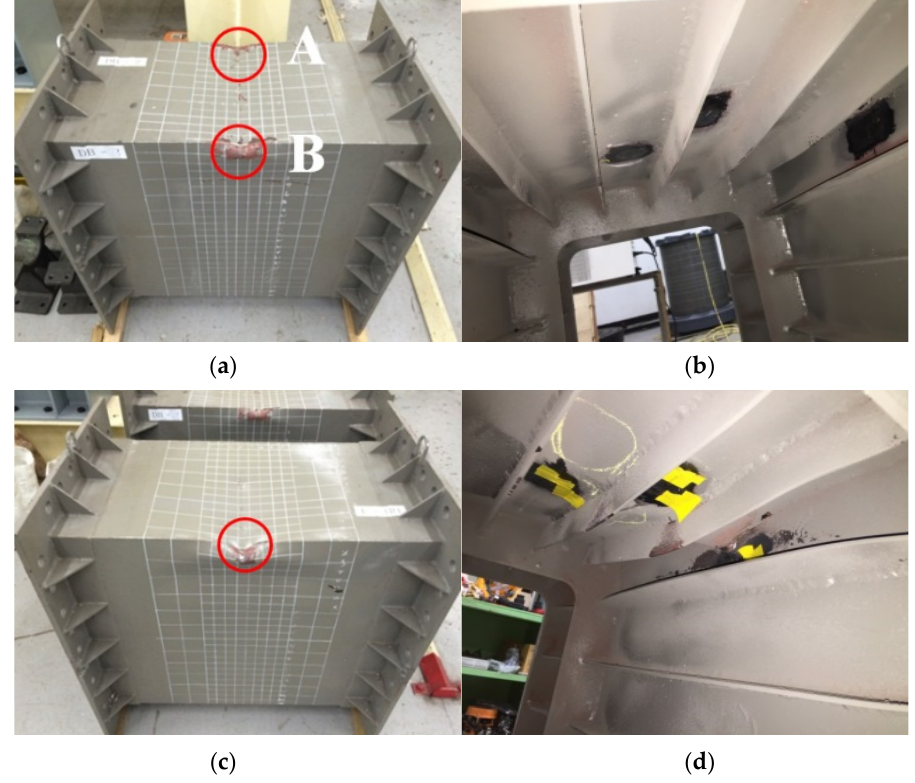
Figure 7. The deformed shape of the model: ( a ) DB-2: exterior view (showing locations A and B where the dent depth were measured); ( b ) DB-2: interior view; ( c ) DB-4: exterior view; ( d ) DB-4: interior view. Table 3. Conditions of the collision tests: denting damage.